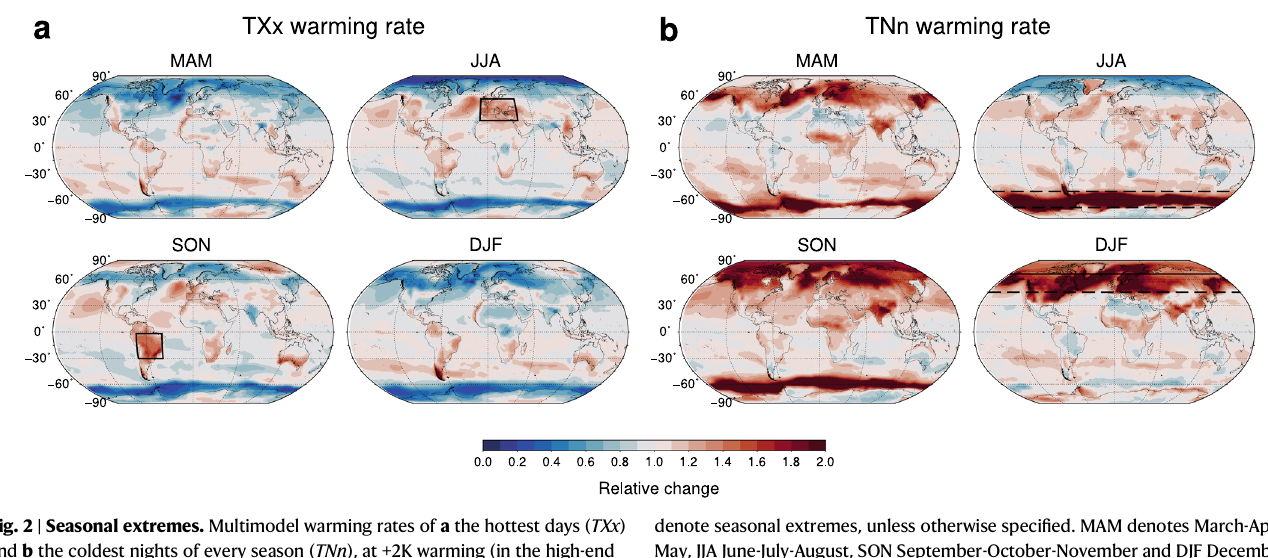
denote seasonal extremes, unless otherwise speci fi ed. MAM denotes